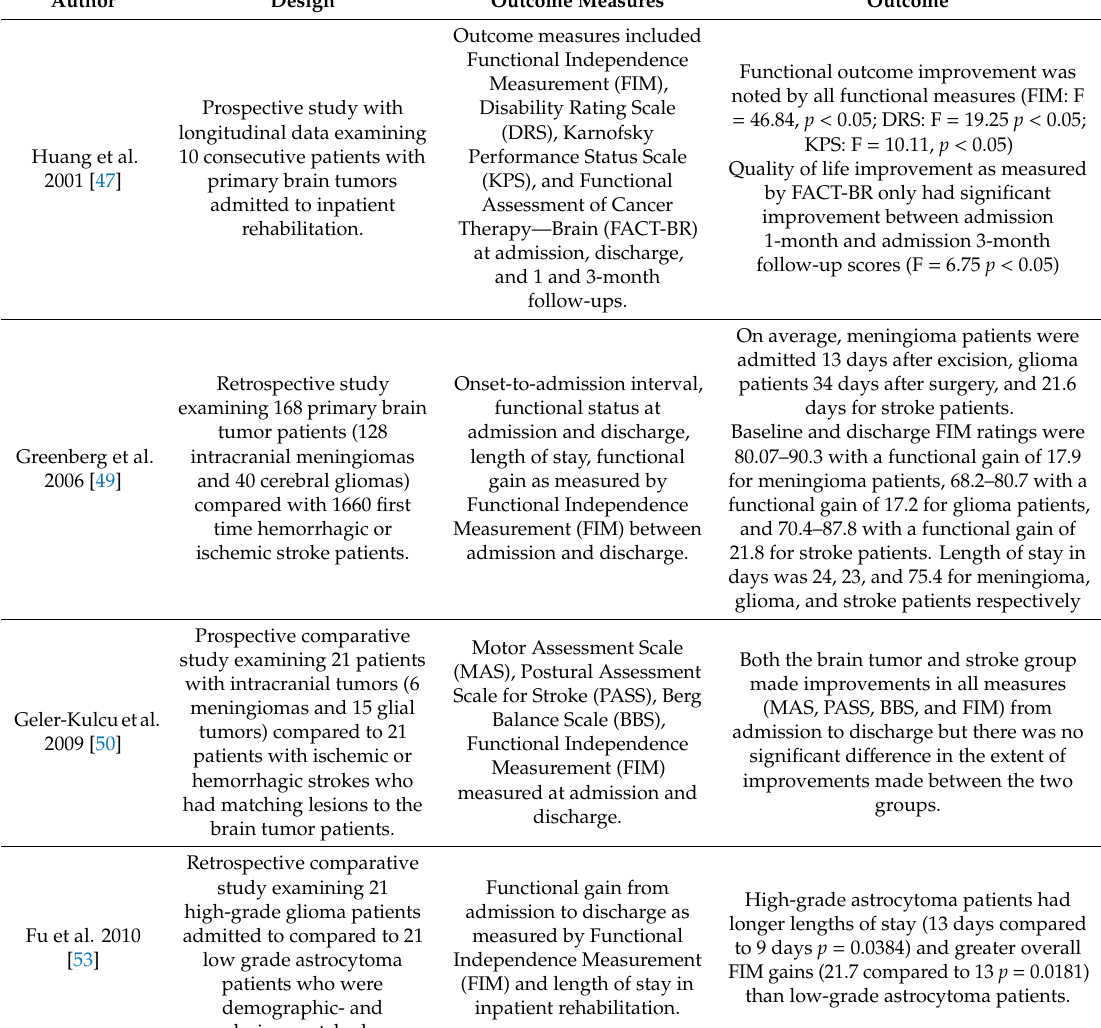
Table 2. Comparison of inpatient rehabilitation for patients with primary brain